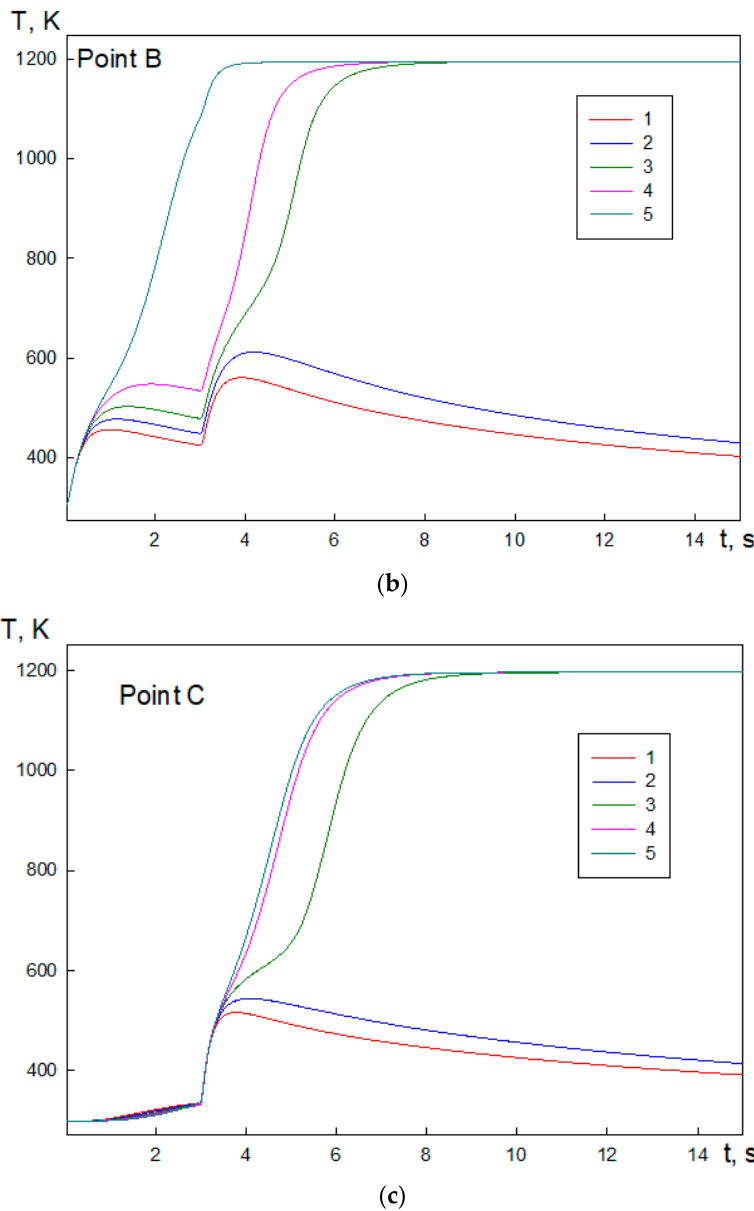
Figure 9. Temperature change over time: ∆ t = 3 s, h = 6.5 mm, 1—L = 69 mm, d = 3.5 mm, 2—d = 4.5 mm, 3—d = 5.5 mm, 4—d = 6.5 mm, 5– d = 7.5 mm.